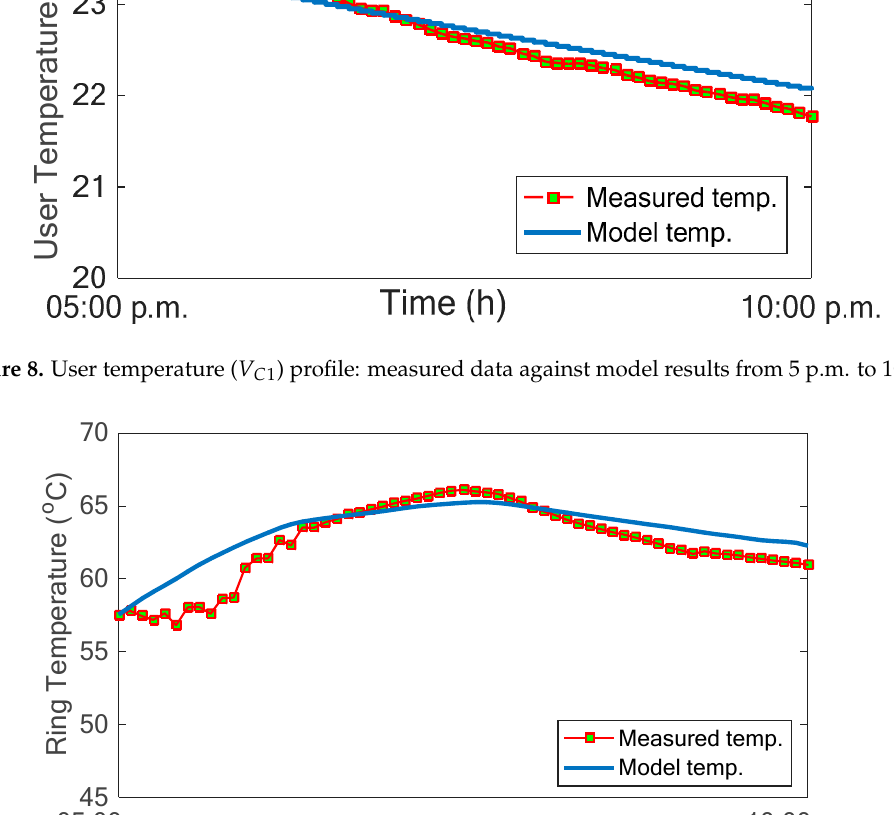
Measured temp. Model temp. 10:00 p.m. Time (h)